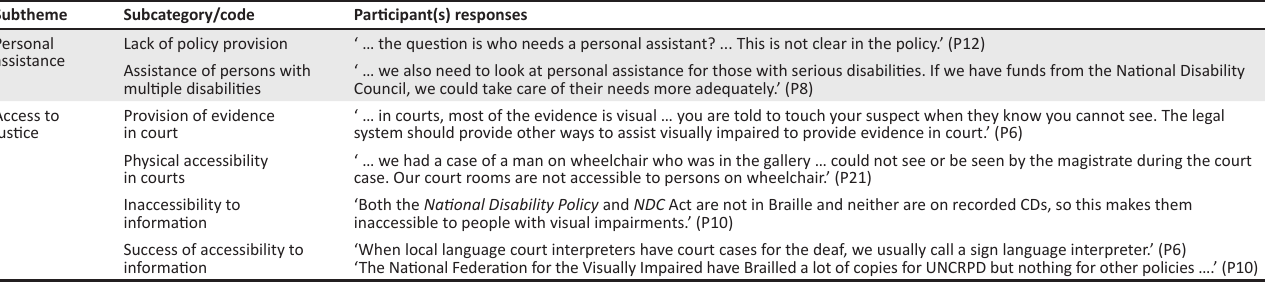
TABLE 8: Key theme 5: Empowerment. Subtheme Subcategory/code Participant(s) responses Advocacy and Disability desk in offices/ communication